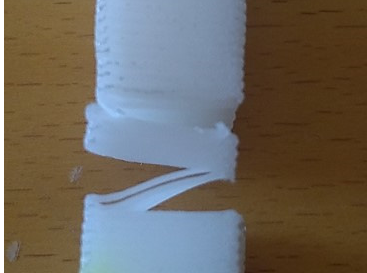
Figure 4. Macrographic image showing the loss of cohesion between the printed layers of the P v